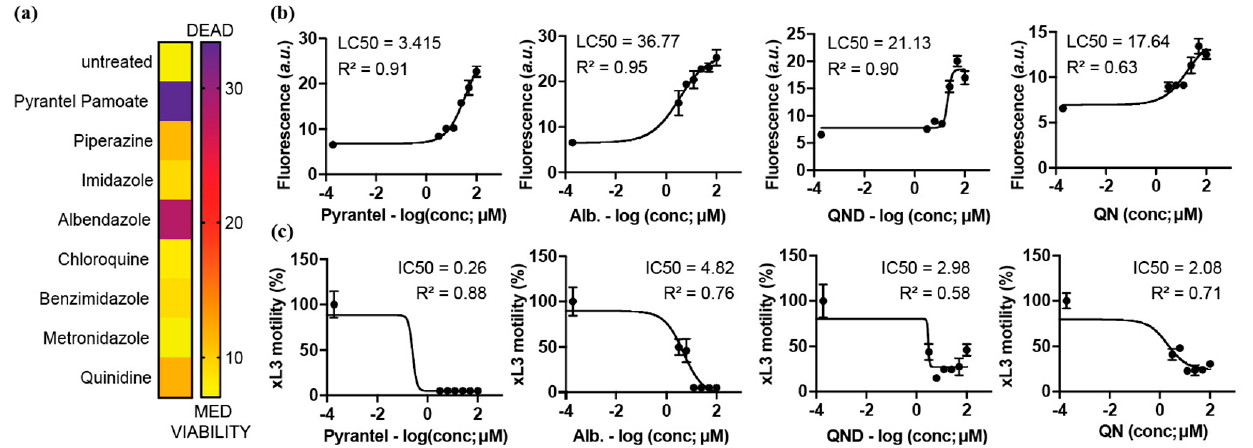
Figure 2. ( a ) N. brasiliensis iL3s ( n = 100) were co-cultured in the presence of RBCs with 100 µ M known anthelmintics (pyrantel, piperazine, imidazole, albendazole, chloroquine, benzimidazole, metronidazole and quinidine). After 3 days, Sytox Green was added to the wells and 24 h later, fluorescence (arbitrary units, a.u. ) was measured by spectrophotometry. The average of duplicate values for each drug are shown as a heat-map ranging from medium viability (MED) to low viability (DEAD i.e., equivalent to killed by boiling) (arbitrary units a.u. ). ( b ) Drug dilution series for pyrantel, albendazole (Alb.), quinidine (QND), and quinine (QN) using the same assay as described in ( a ). Data were normalised to those for “dead” controls and pooled from three independent experiments and represented as mean ± standard error of the mean (SEM). The compound concentrations were log10-transformed and fitted using a variable slope four-parameter equation, using ordinary least squares fit model. ( c ) Using the same conditions as described in ( b ), motility was assessed by microscopy 4 days after culture. Motility scores were calculated for individual compounds, normalised with reference to the negative control (100% motility) and recorded as percentages. Data points represent one experiment conducted in triplicate; mean ± standard error of the mean (SEM). To assess the sensitivity of our assay, we further evaluated the lethal concentration 50 (LC50) values for pyrantel, albendazole, quinine, and quinidine (QND) employing the Sytox Green-based assay for viability, and compared the resultant data to the IC50 calculated using the current ‘standard’ assay [30,31] of assessing worm motility (Figure 2b,c). Interestingly but unsurprisingly, the LC50 values were significantly higher than the IC50 values based on motility. Indeed, change in worm motility is usually observed long before killing actually occurs (and thus can be measured by sytox-Green staining), especially in the case of compounds causing